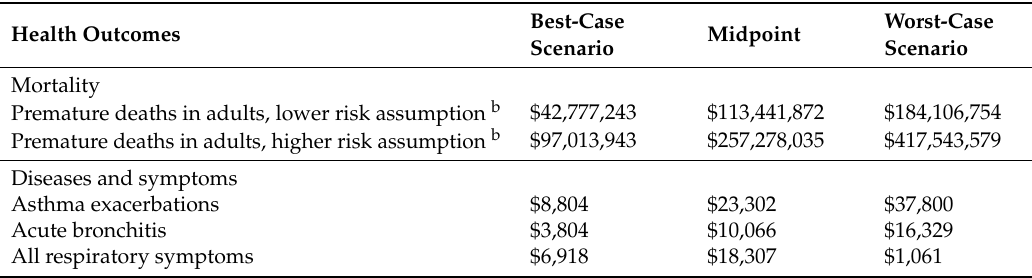
Table 2. Estimated annual economic costs (2010 US dollars) of premature deaths, hospital admissions, and diseases attributable to Volkswagen vehicles’ lack of compliance with EPA standards in the United States a